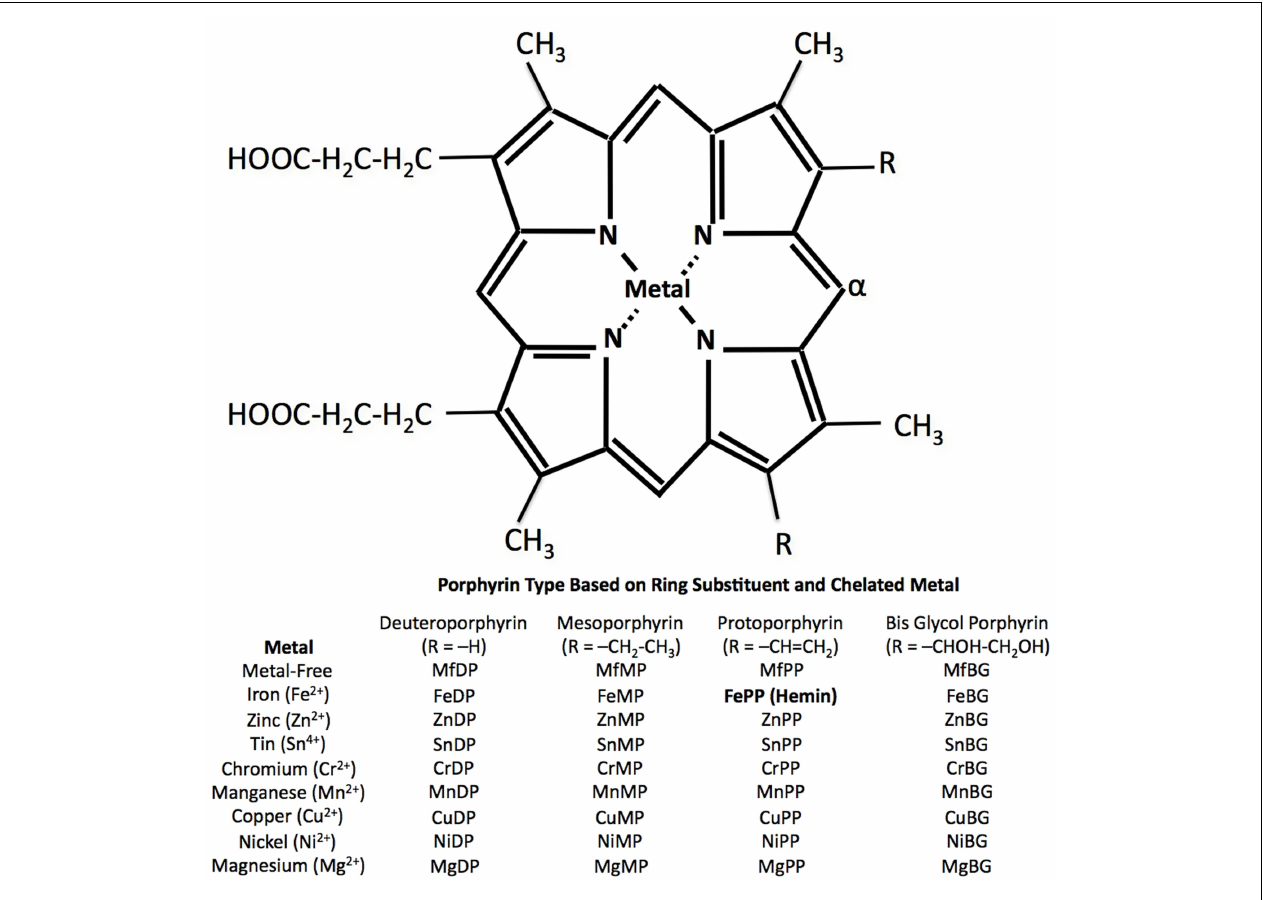
FIGURE 3 | Basic porphyrin IX structure with central metal and two ring substitution sites (R). Oxidation of susceptible porphyrins, catalyzed by HO, occurs at the α -position to yield a tetrapyrrole. Modified fromVreman et al.